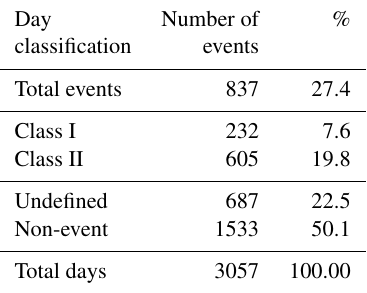
Table 1. Total available measurement days and percentage of NPF events observed at Finokalia during the period June